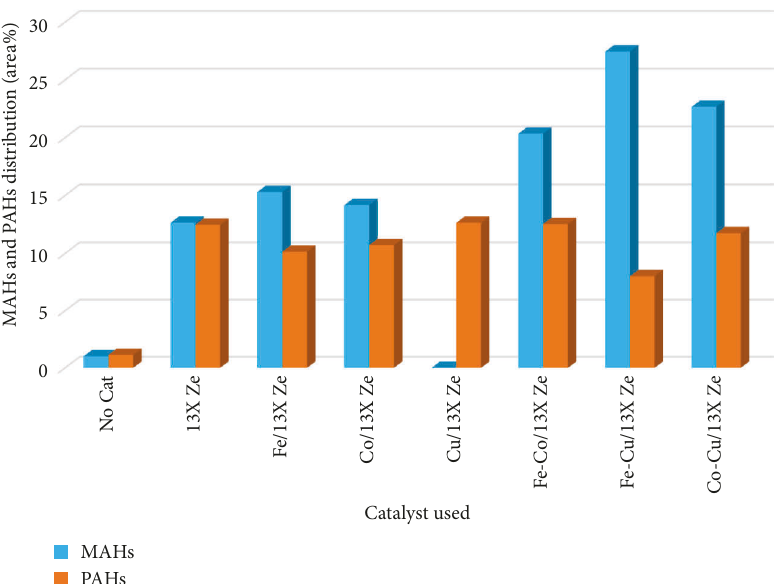
Figure 10: Effects of the metals/13X zeolite catalysts on the distribution of MAHs and PAHs compounds in the bio-oil composition obtained by RRB